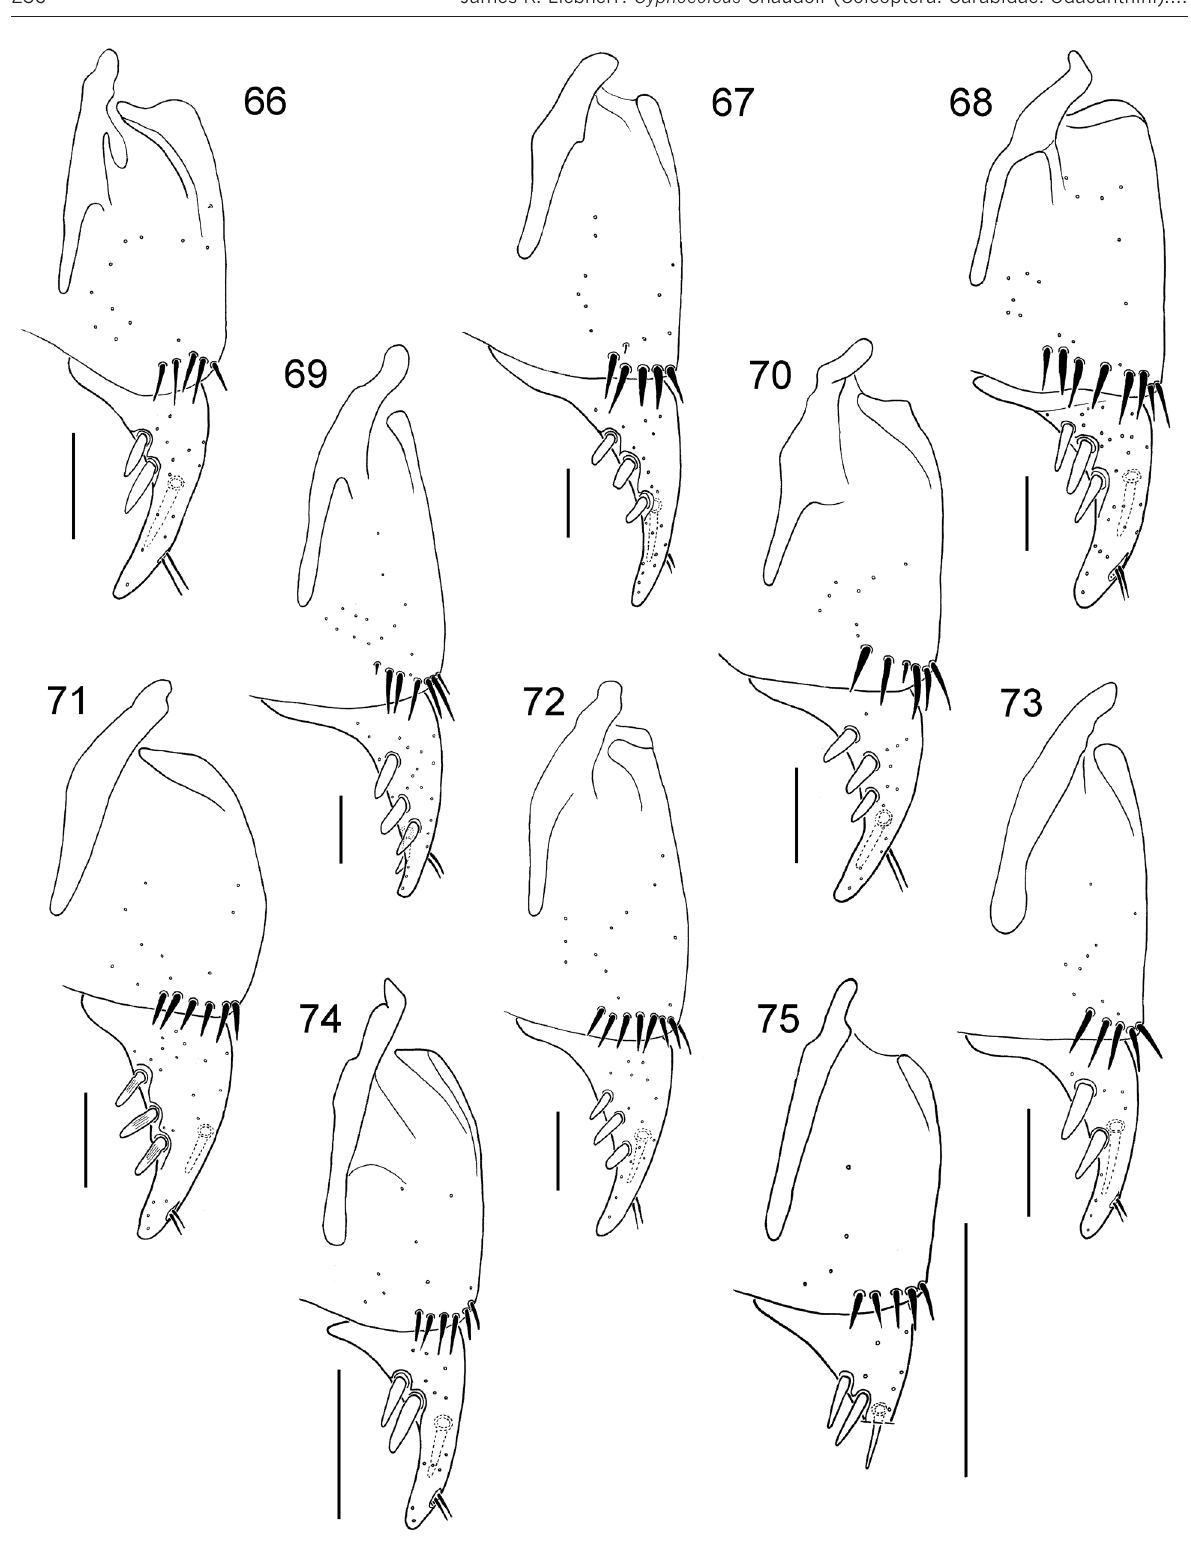
Figures 66–75. Female right gonocoxae, ventral view, for Cyphocoleus spp. illustrating apical fringe setae of basal gonocoxite 1, and two or three lateral ensiform setae, one dorsal ensiform seta, and two apical nematiform setae on apical gonocoxite 2; 66 , C. lissus , Mt. Humboldt; 67 , C. prolixus , Mt. Humboldt; 68 , C. heterogenus , Yahoué; 69 , C. parovicollis, Mandjélia; 70 , C. ovicollis , Ningua Res.; 71 , C. burwelli , Mt. Humboldt; 72 , C. monteithi , Mt. Mou; 73 , C. miricollis , Forêt Nord; 74 , C. mirabilis , Mt. Koghi; 75 , C. lescheni , apical gonocoxite damaged, Aoupinié. Scale bar, 0.10